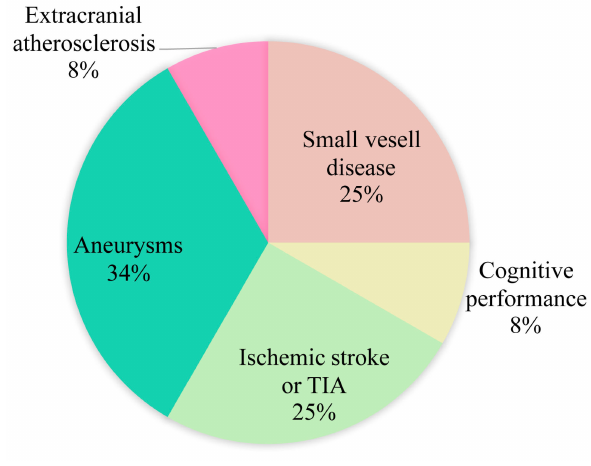
Figure 2. Distribution of studies on intracranial vessel wall lesions related neurological disorders. Abbreviations: TIA, transient ischemic